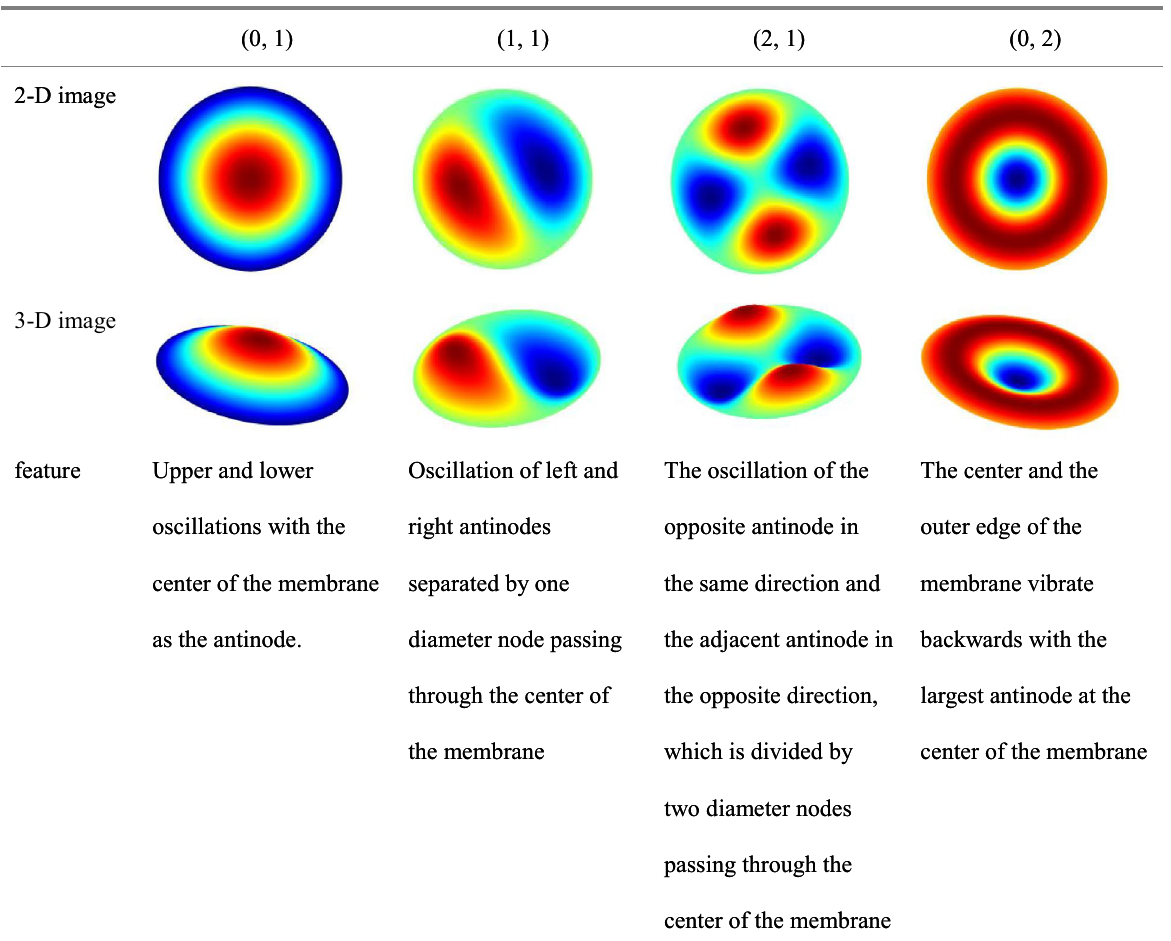
Table 2 Four typical modes of circular membrane oscillation